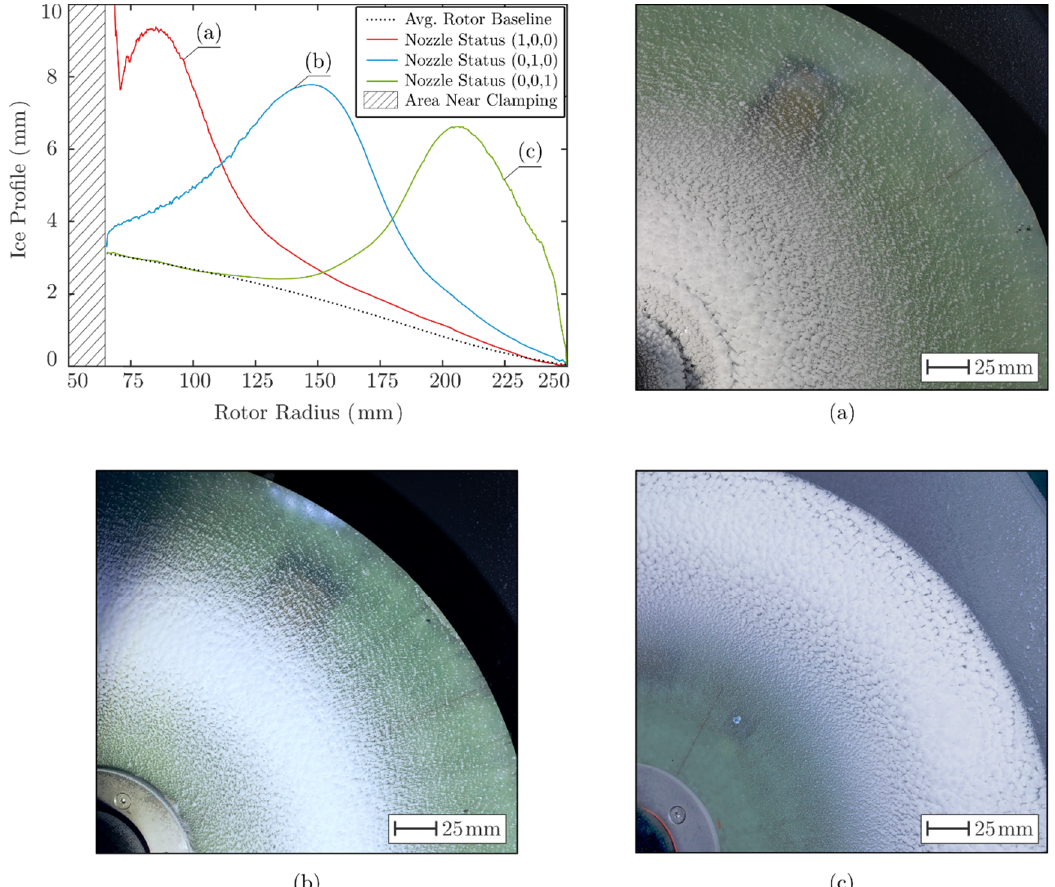
Figure 6. Thickness profile of ice accumulation along the radius of the rotor at constant rotational speed using three different nozzle configurations to form ice on the inner radius ( a ), in the centre ( b ) and on the outer radius of the rotor ( c ).